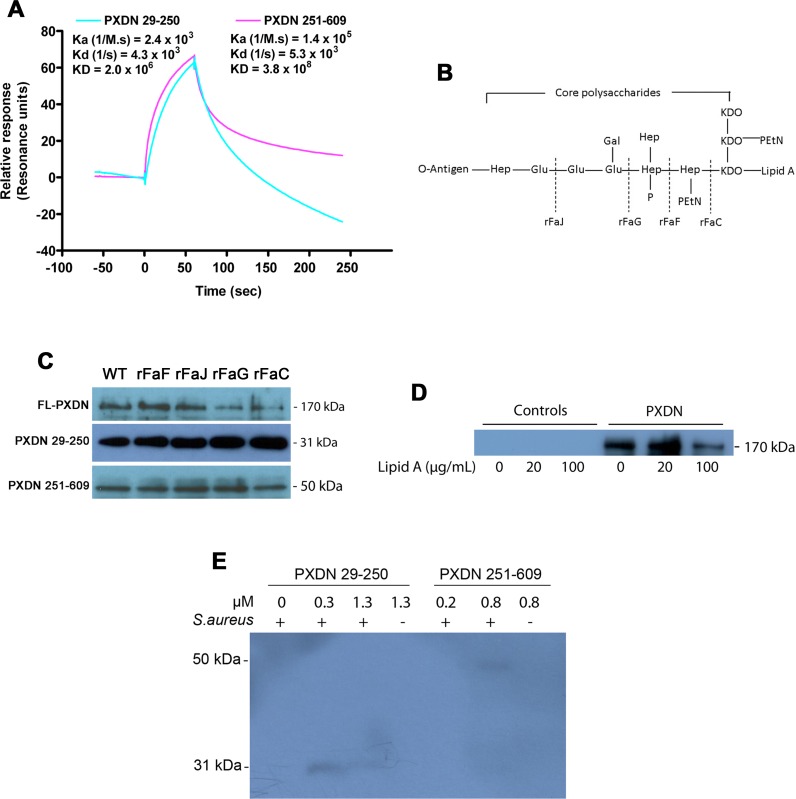
PXDN interacts with LPS.(A) PXDN binding to LPS determined by SPR. Recombinant peptides of PXDN 29-250aa or PXDN 251-609aa were immobilized on a NTA chip, and LPS (2 μM) was flowed over the chip. The binding data were collected and analyzed with Biacore T200 software. Data are the representatives of three independent experiments. (B) The typical structure of E. coli LPS and genes determining the biosynthesis of LPS. Dash indicates the stage point of LPS synthesis by the corresponding gene. KDO, 3-deoxy-D-manno-oct-2-ulosonic acid; Hep, L-glycero-D-manno-heptose; EtN, ethanolamine; Gal, D-galactose; Glu, D-glucose; P, phosphate. (C) Interaction of PXDN with LPS-deficient strains of E. coli. The binding experiments of truncated PXDN to LPS-deficient E. coli strains were carried out as in Fig 1B and 1E. 100 nM of FL-PXDN or truncated PXDN were utilized. rFaF, rFaJ, rFaG and rFaC are the LPS-deficient E. coli strains with mutation of related gene. “WT” is wild-type of E. coli K12 BW25113, which is the parent strain of LPS-deficient E. coli strains. Data are representatives of three independent experiments. (D) Lipid A inhibits PXDN binding to GN bacteria. Lipid A was mixed with E. coli K12 and PXDN similar to Fig 1B. The pellets were washed twice and subjected to immunoblotting using anti-His antibody. The data are representatives of two independent experiments. (E) The binding capacity of PXDN to GP bacteria is limit. Recombinant peptides of PXDN 29-250aa or PXDN 251-609aa were added to live bacterial suspensions of S. aureus, similar to Fig 1E. The bacterial lysates were subjected to immunoblotting using anti-His antibody and visualized by chemiluminescence. Data are representatives of three independent experiments.